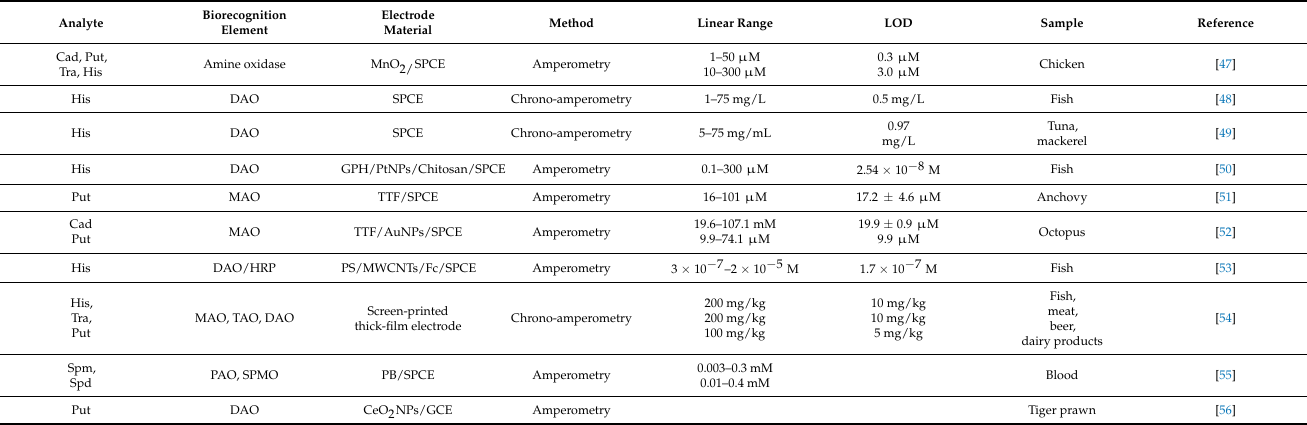
Table 1. Enzyme-based electrochemical biosensors for biogenic amine determination in fish and